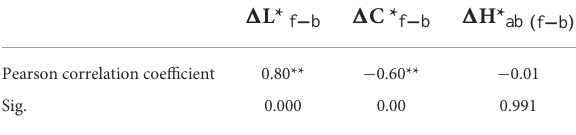
TABLE 3 Pearson correlation between 1 E * f − b and 1 L * f − b , 1 C * f − b , and 1 H * ab (f − b) .